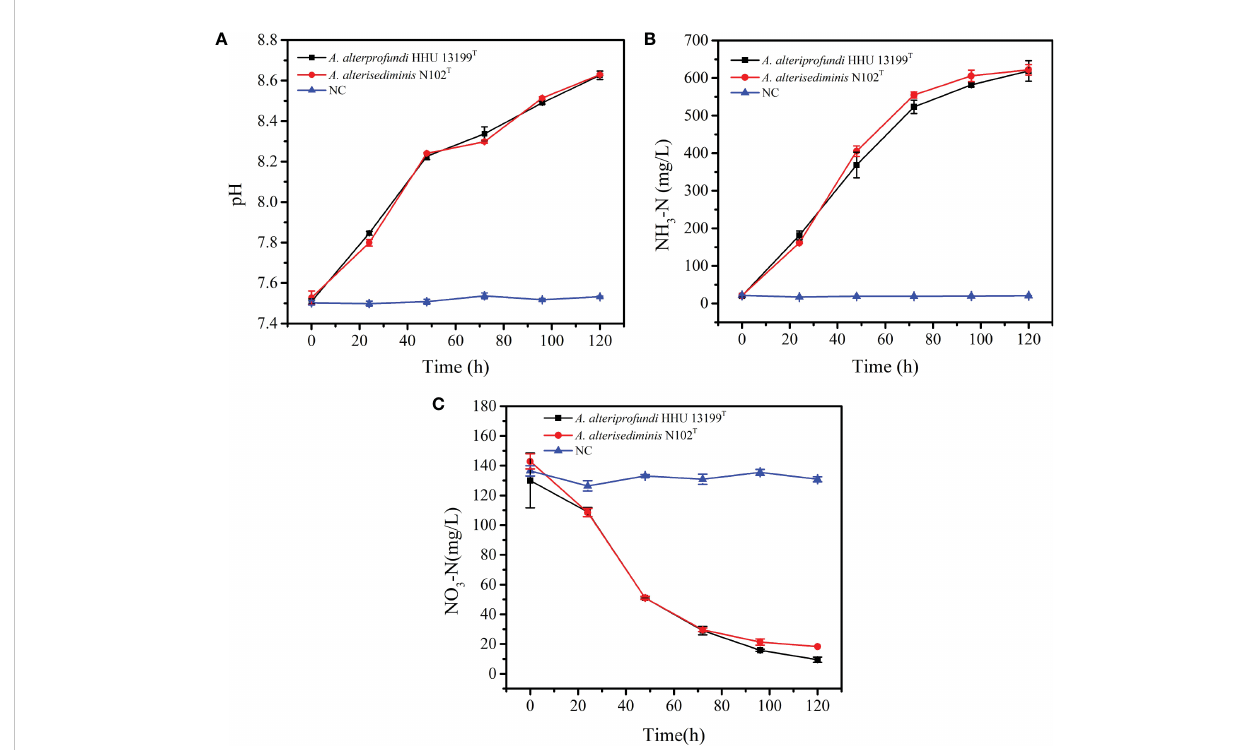
FIGURE 3 Changes in pH value, NH 3 -N, and NO 3 -N concentration in 2216E medium during the incubation of strains A. alteriprofundi HHU 13199 T and A. alterisediminis N102 T . (A) , pH value; (B) , NH 3 -N concentration; (C) , NO 3 -N